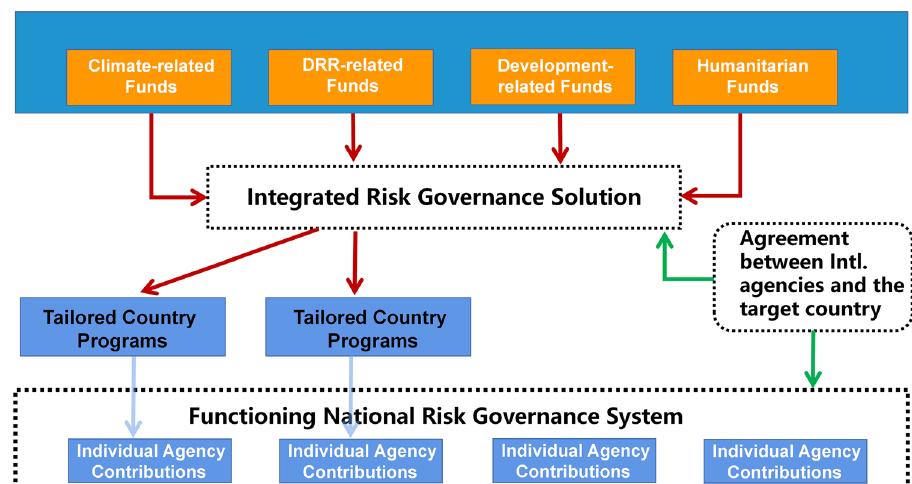
Fig. 7 Integrated risk govern- ance solution among inter- national organizations and